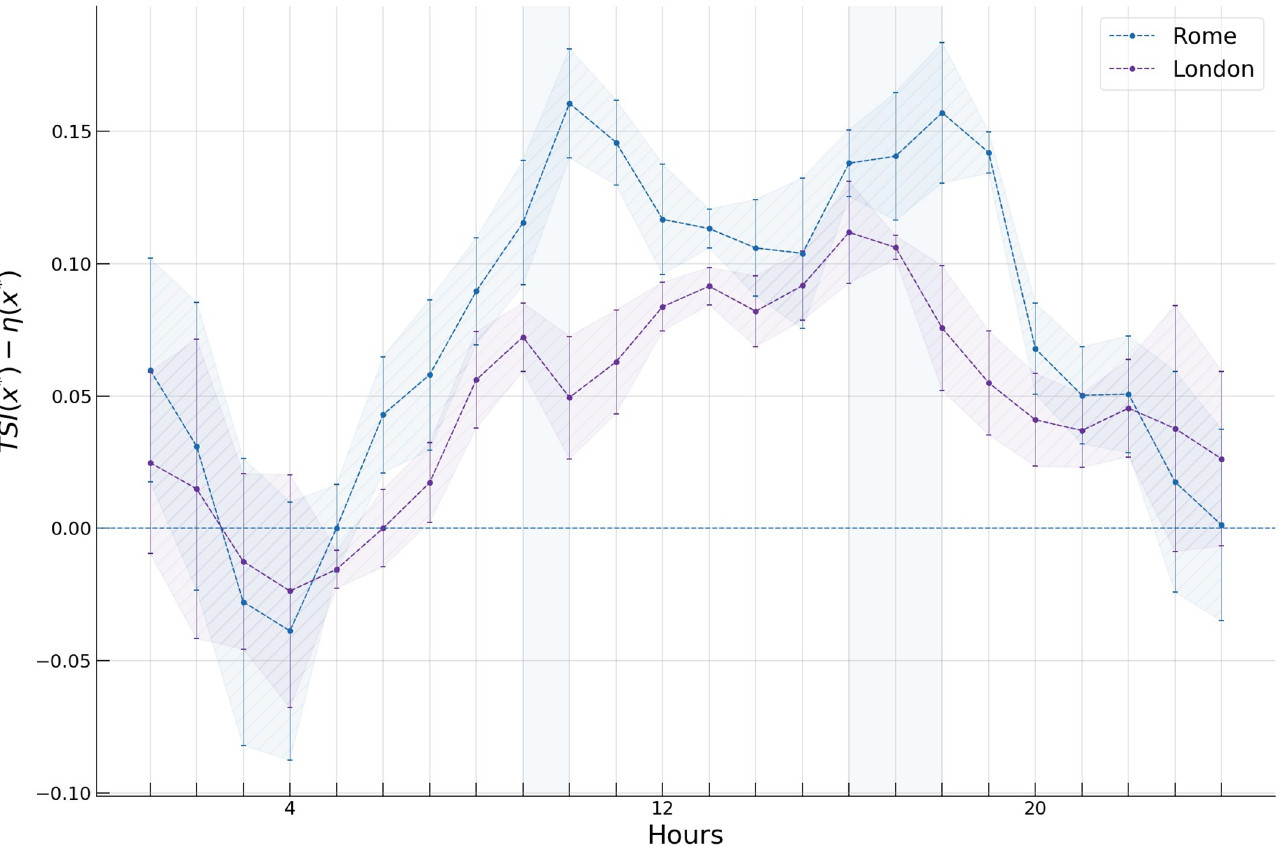
Fig 14. Retail APA values at 18:00 in Rome represented with pairwise time-weighted distances between grid cells using multidimensional scaling ( MDS ). The inset shows the same set of values in geographical space.